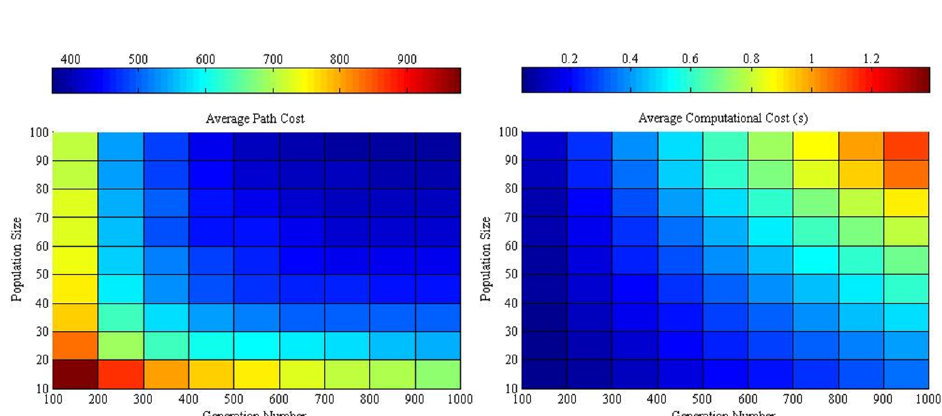
Fig 6. Optimum crossover and differential weight for various population sizes and generations “ Table C in S1 Dataset. ”